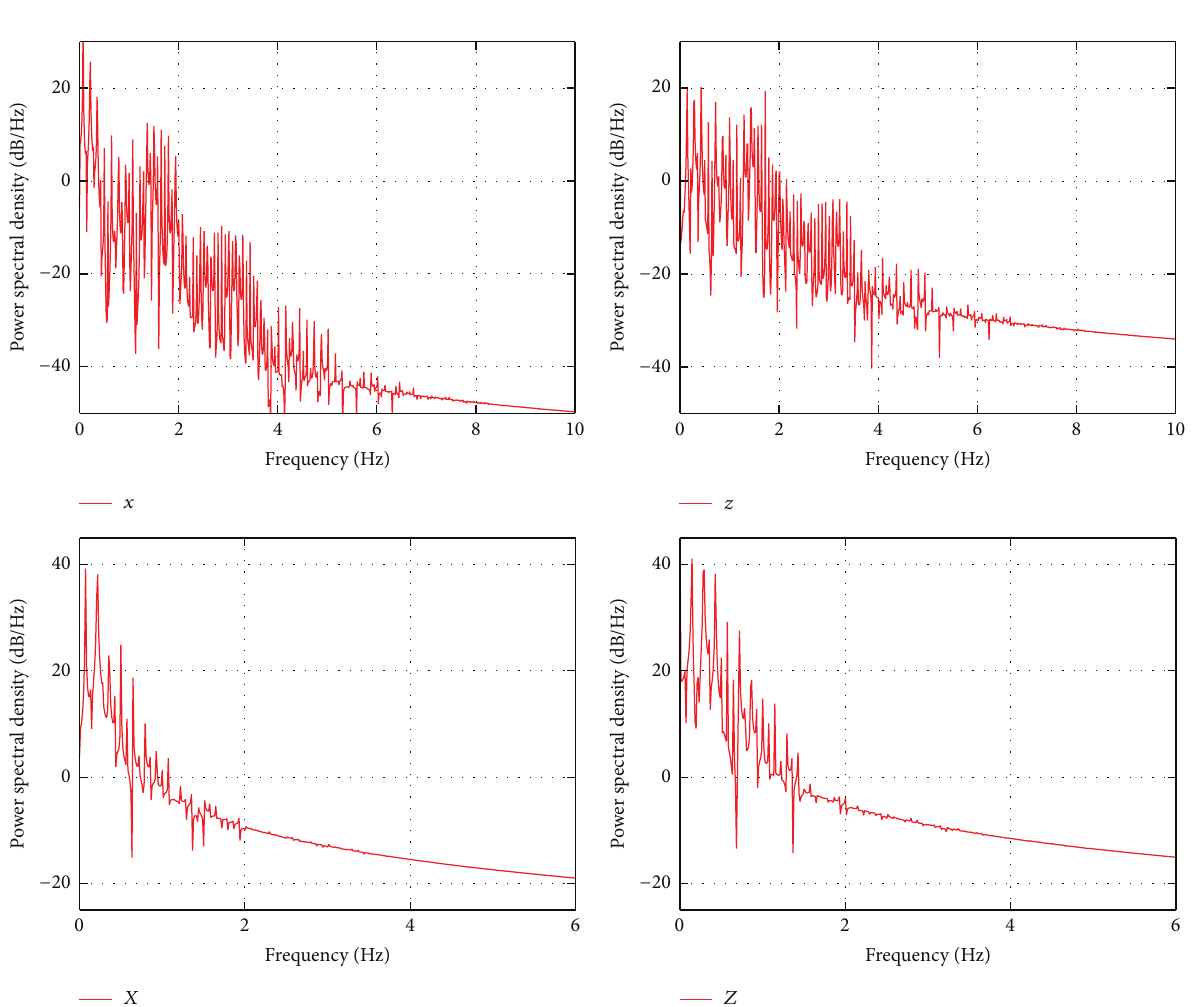
The ACF and spectrum represent different characteriza- tion of the same time series information. However, the ACF analyzes information in the time domain and the spectrum in the frequency